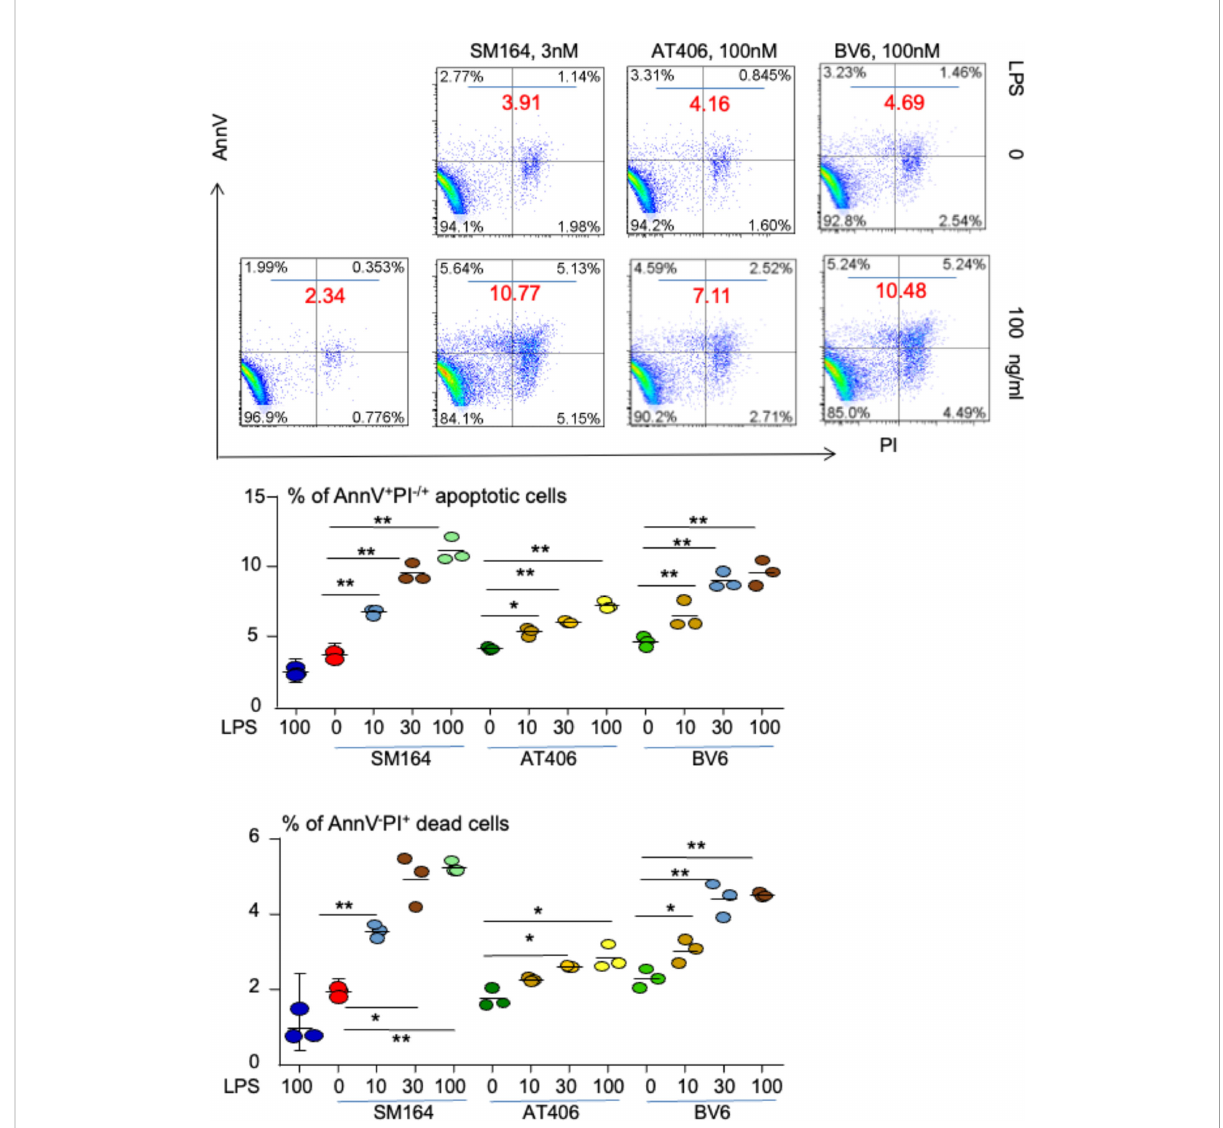
FIGURE 1 LPS triggers IAP antagonist-induced apoptosis of MDA-MB-231 cells. 1 × 10 5 MDA-MB-231 cells were cultured in 60-mm dishes for 24 h followed by treatment overnight with indicated dose of SM-164, AT-406, or BV6 − /+ LPS. AnnV + PI − /+ apoptotic cells were analyzed by fl ow cytometry. The data were from three repeat samples in one experiment. *p < 0.05 and **p < 0.01 between the indicated groups. The experiments were repeated three times with similar results. LPS, lipopolysaccharide; IAP, inhibitor of apoptosis